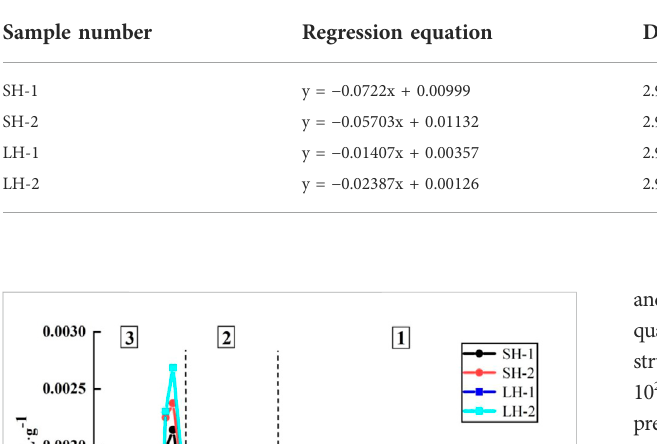
TABLE 4 Statistics of the fractal dimension of coal samples.